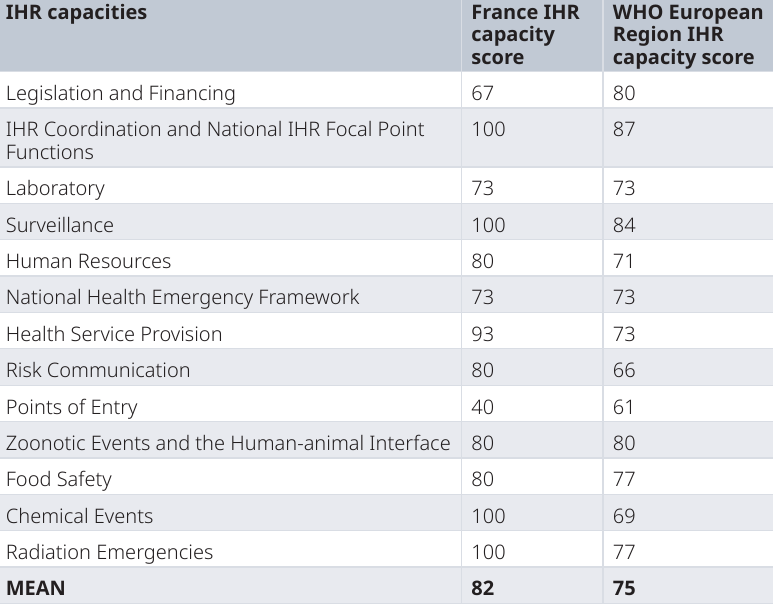
Table 1. International Health Regulations (IHR) capacity scores in France in